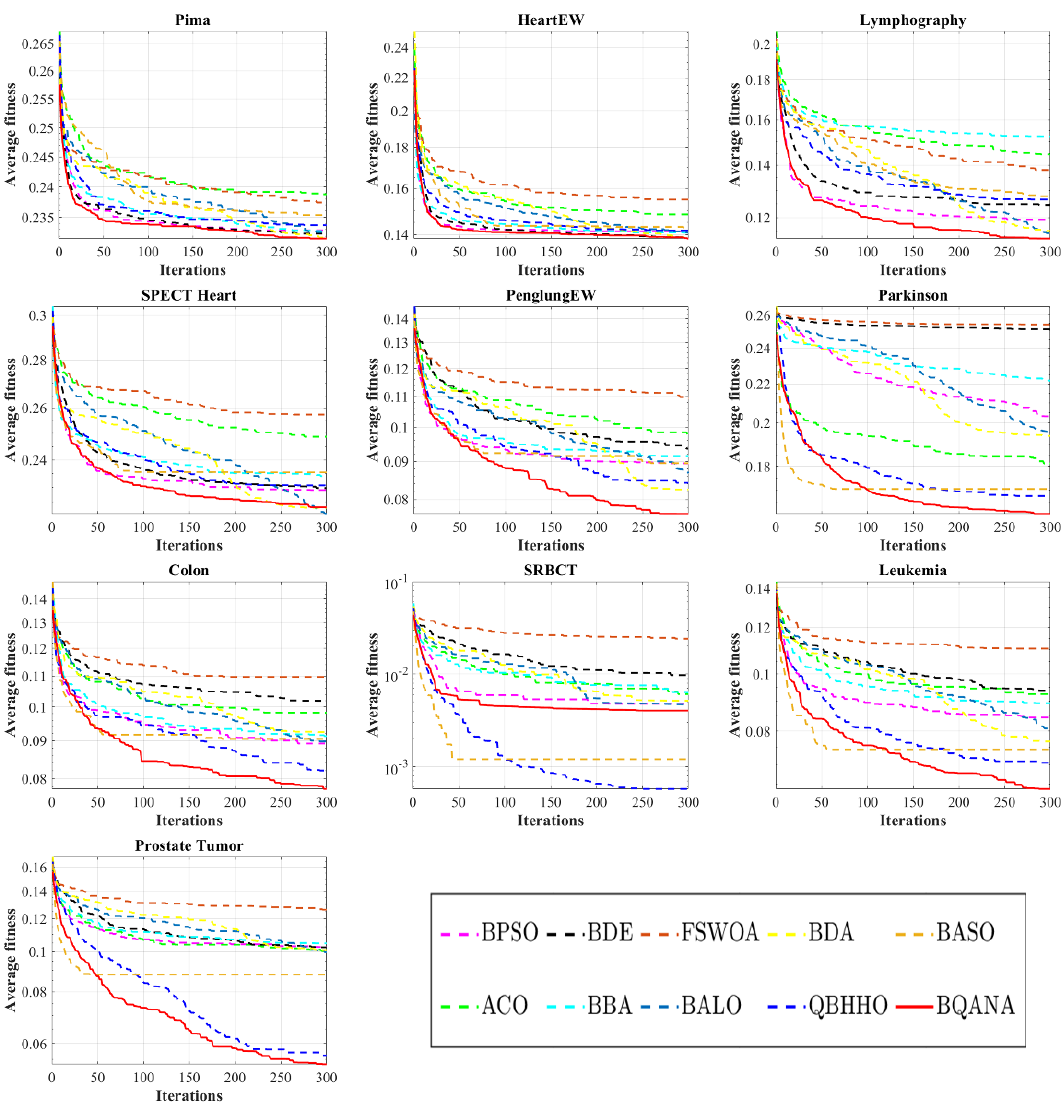
Figure 9. Convergence behavior of the BQANA and comparative algorithms. Table 7. The Friedman test for the fitness obtained by each